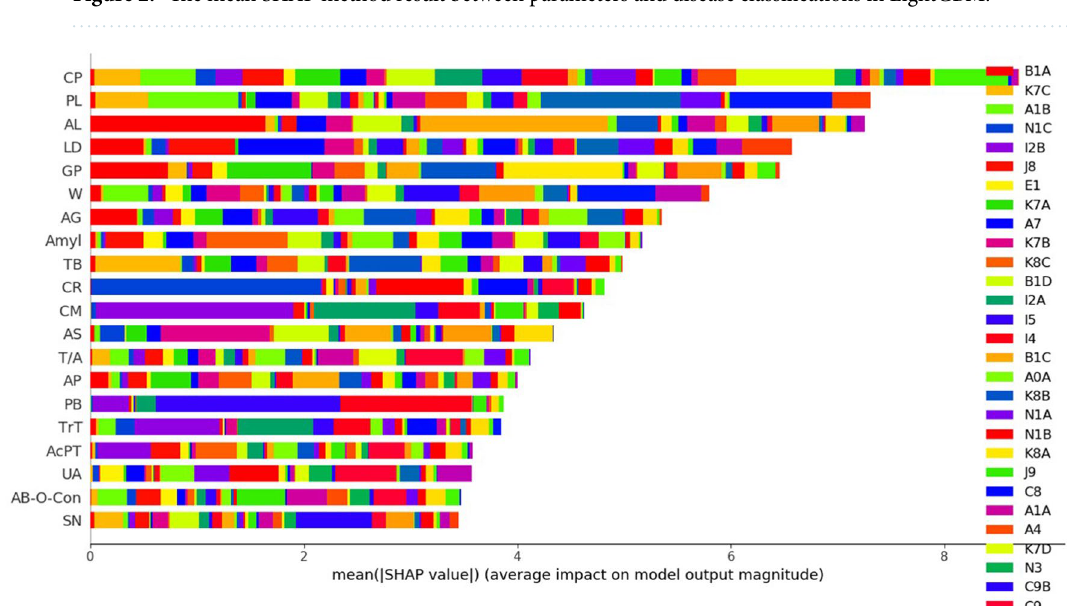
Figure 3. The mean SHAP method result between parameters and disease classifications in